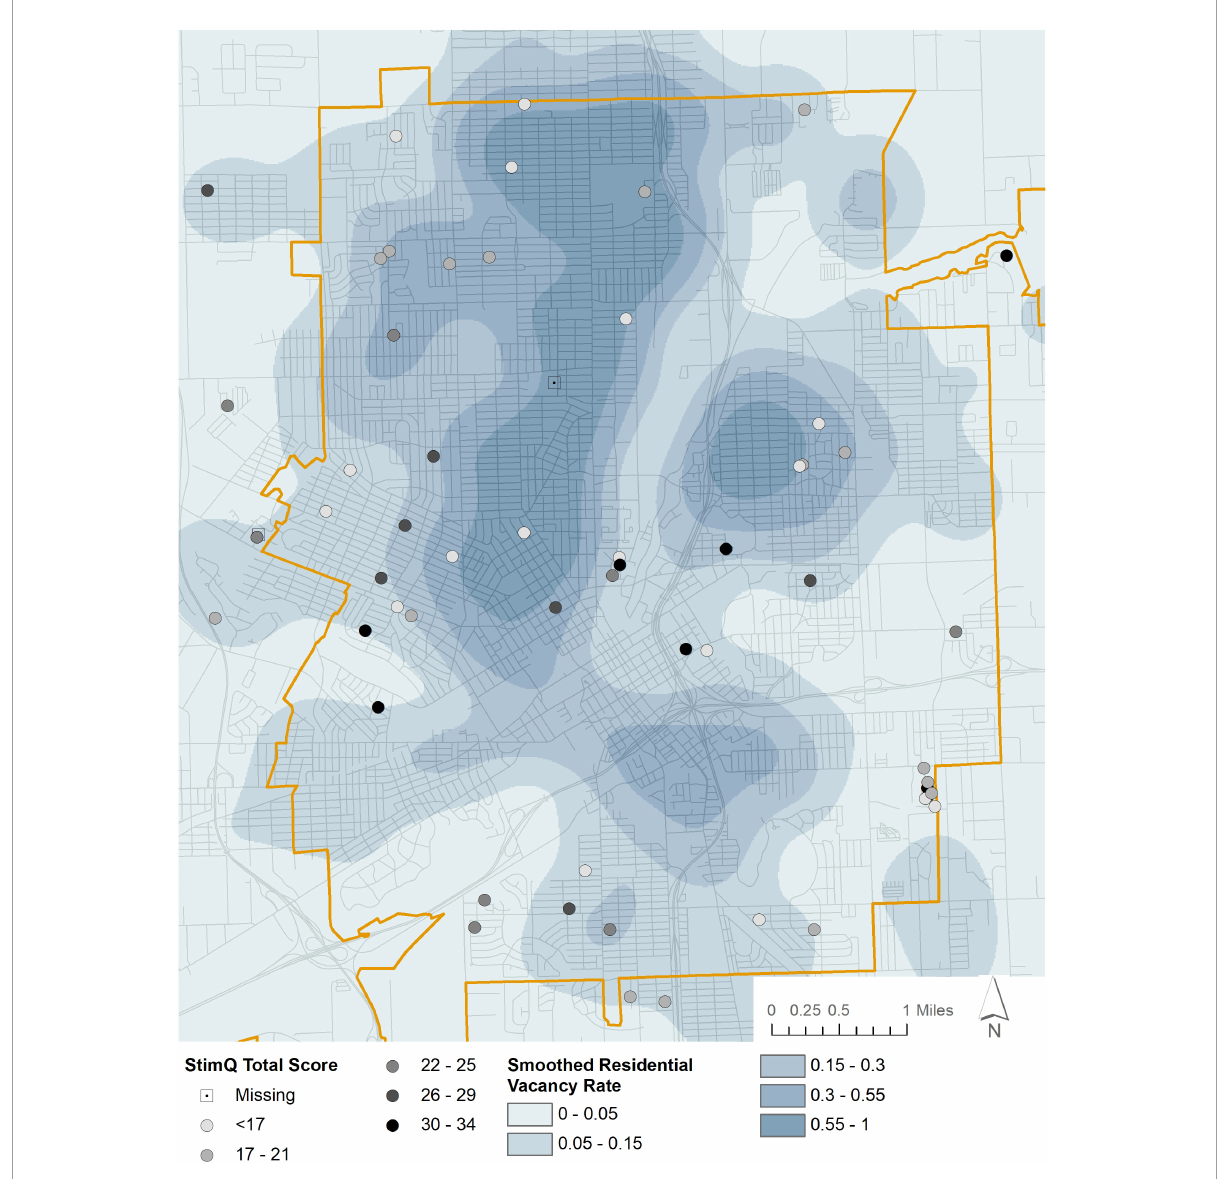
FIGURE1 Parental cognitive stimulation (StimQ 2 ) and neighborhood vacancy